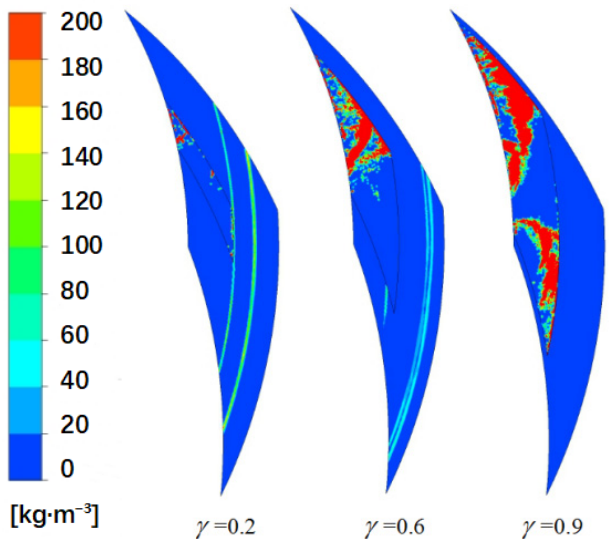
Figure 15. Particles’ distribution with different groove width ratios.